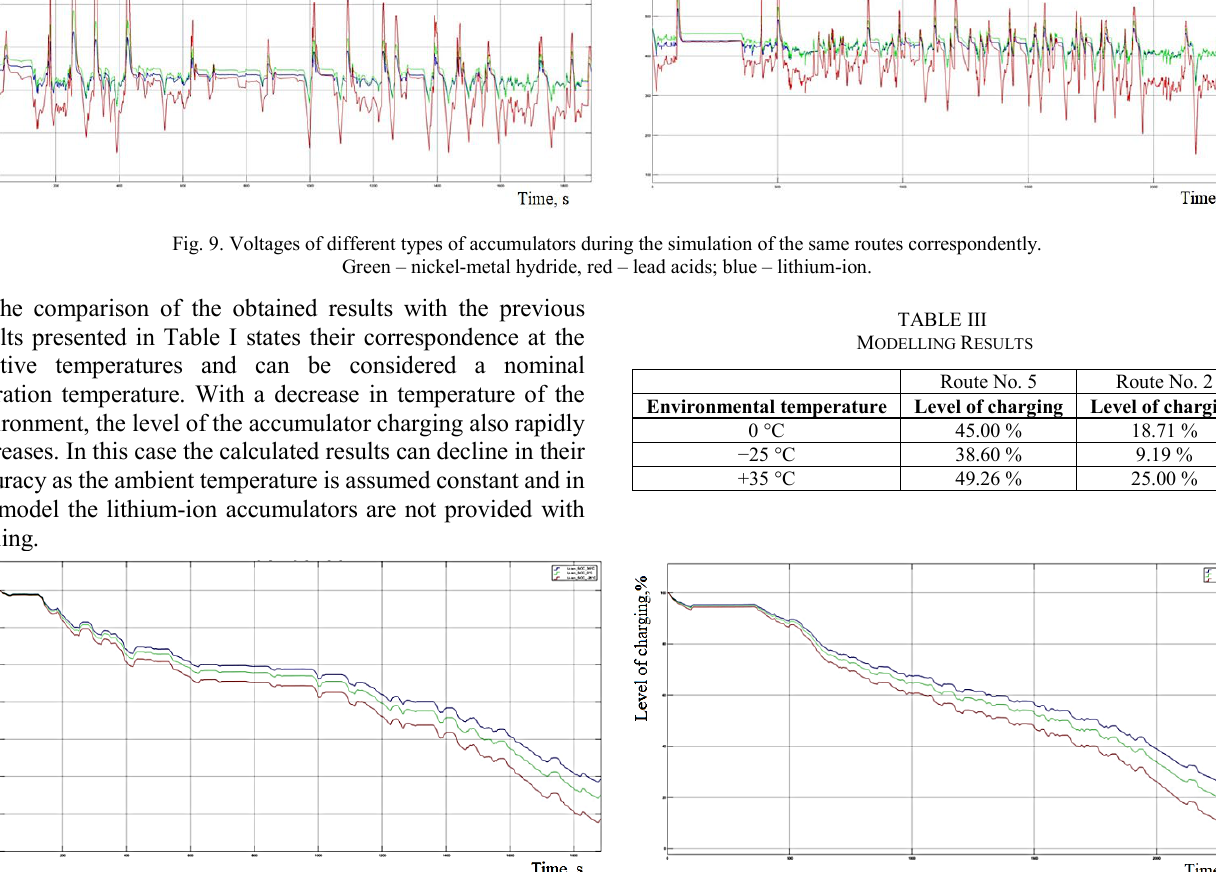
Fig. 10. Voltages of different types of accumulators during the simulation for routes No. 5 and No. 2. Green – at 0 °C; red – at − 25 °C; blue – at +35 °C.